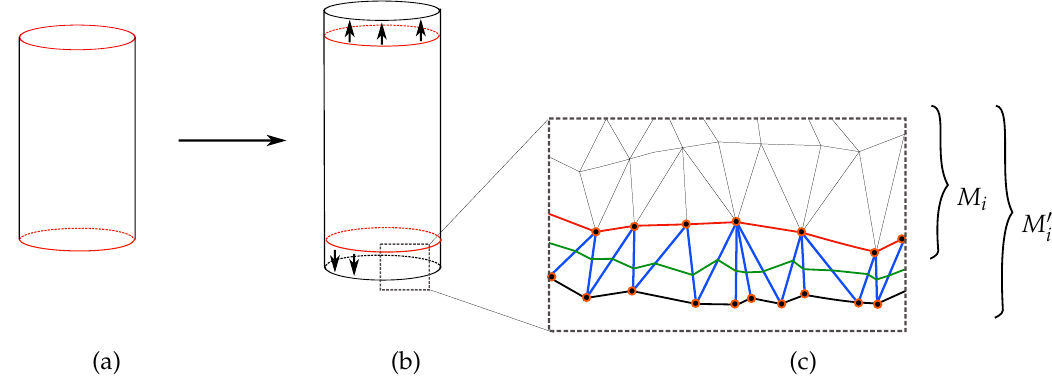
Figure 11. An illustration of the partition stage. ( a ) A connected component of the submanifold M i is obtained. ( b ) M i is extended to M (cid:48) by adding the crossing edges. ( c ) A closeup of the crossing i edges of the manifold M (cid:48) . The blue edges represent the crossings edges of E i − 1 and the green curve i represents the portion of the curve f − 1 ( c i − 1 ) within the closeup